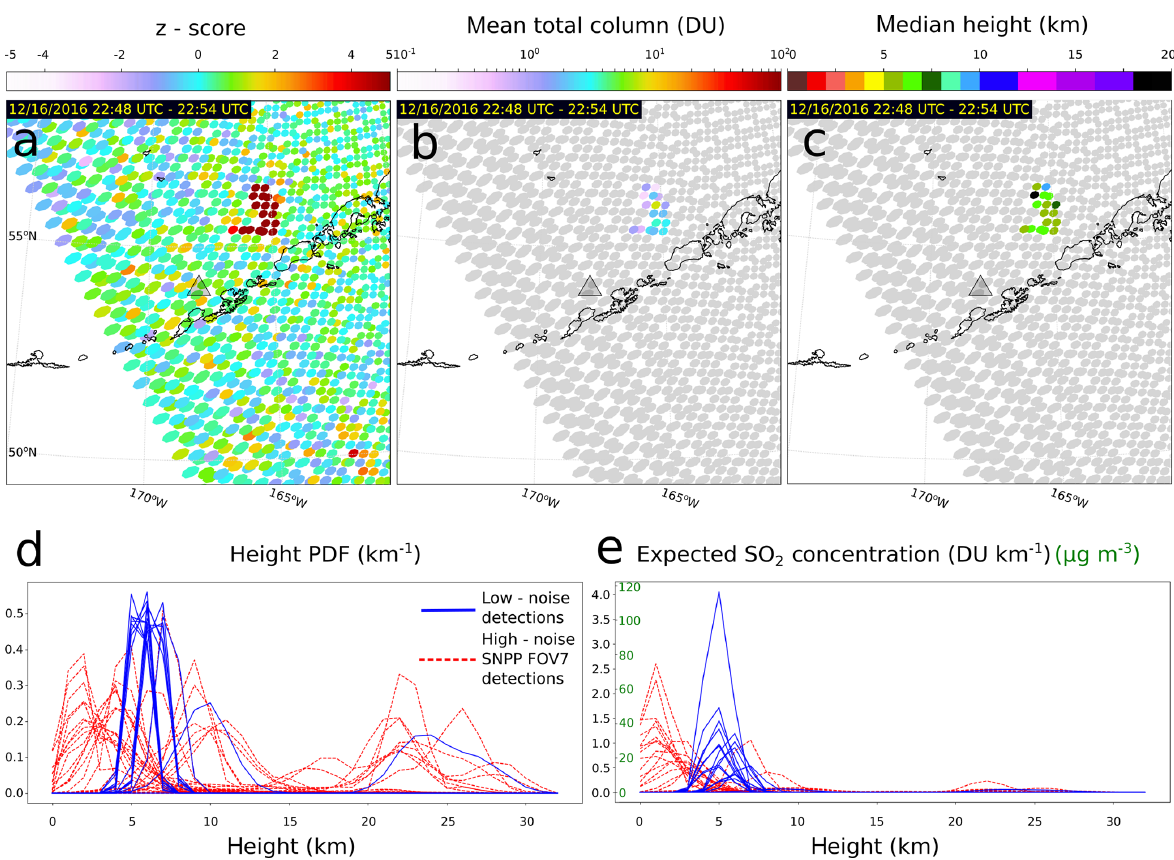
Figure 7. Initial (classical) z score (a) , mean total VCD (b) , and median height (c) for an explosion from Bogoslof very early in the 2016– 2017 eruption (SNPP CrIS). Height PDFs (d) and expected (mean) cloud concentration (e) profiles for the detected SO 2 cloud. Retrievals from the high-noise SNPP CrIS FOV 7 (dotted red lines in d and e ) are not shown in panels (a) – (c)